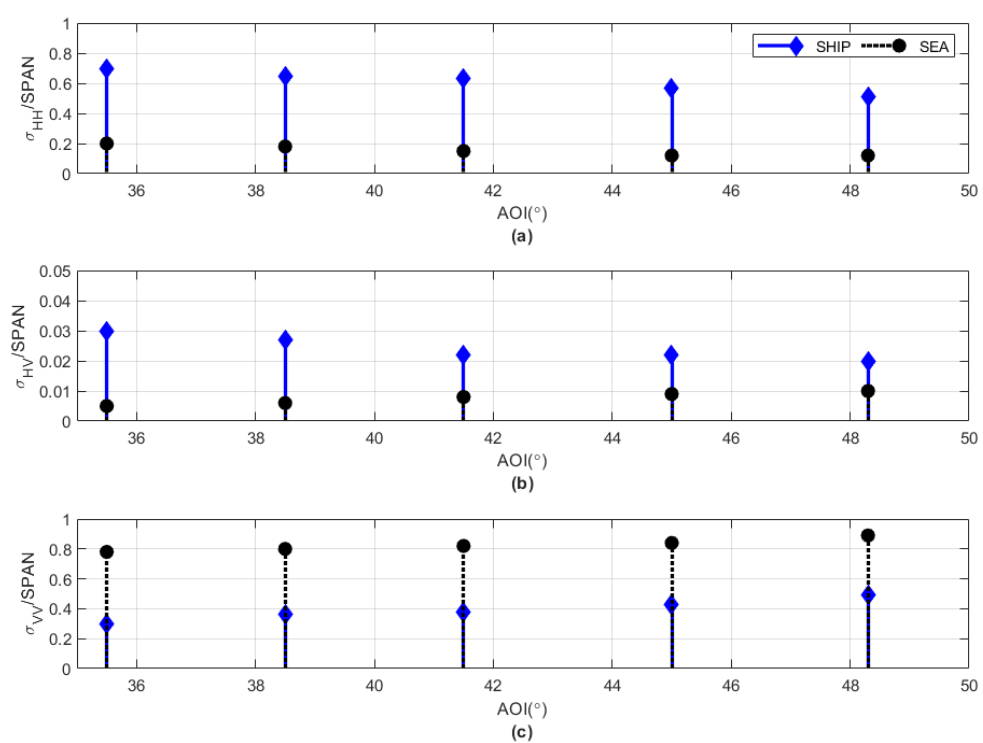
Figure 9. Relative contribution to the SPAN of multi-polarisation NRCSs evaluated over sea (black) and ship (blue) ROIs. ( a ): HH-, ( b ) HV-, and ( c ) VV-polarised NRCS. The linear scale is